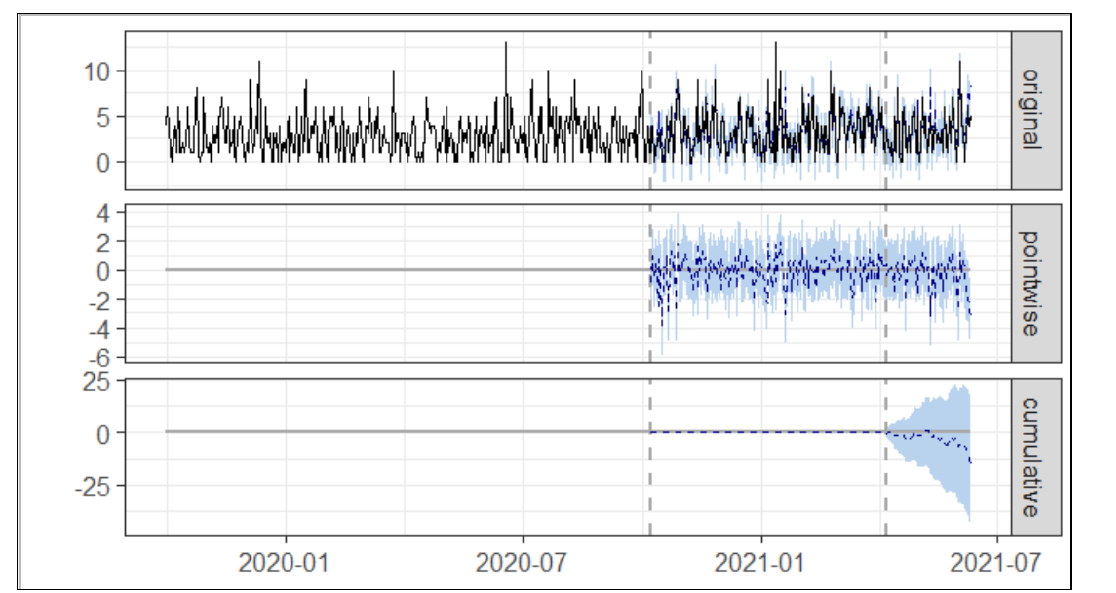
Figure 6. The trend of prescription of Octasa ® post intervention 1 and post intervention 2. Note: The first panel shows the data and a counterfactual prediction for the post-treatment period. The second panel shows the difference between observed data and counterfactual predictions. This is